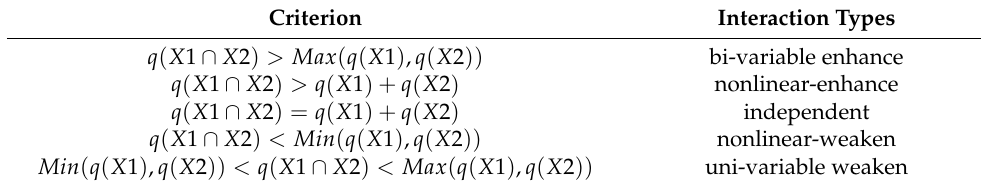
Table 2. Description of interaction